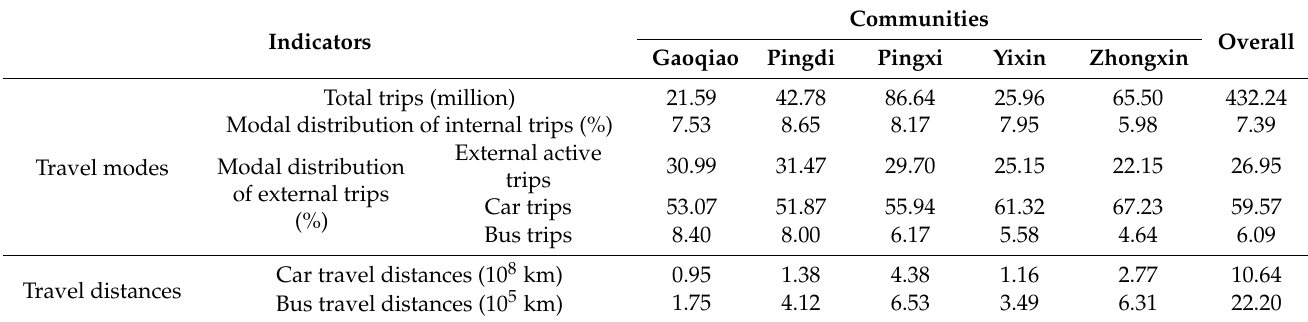
Table 3. Estimated annual travel demand of the ILCC Core Area in